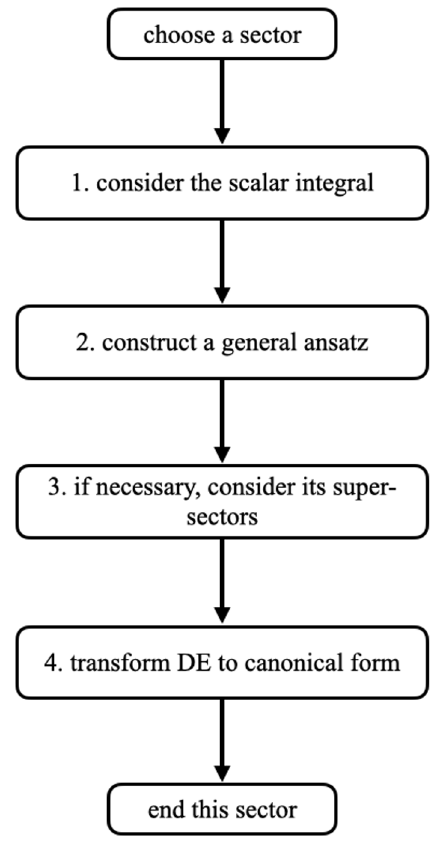
Figure 1 . A schematic algorithm for finding UTs in a specific sector of a Feynman integral family. In steps one to three, a LS analysis is